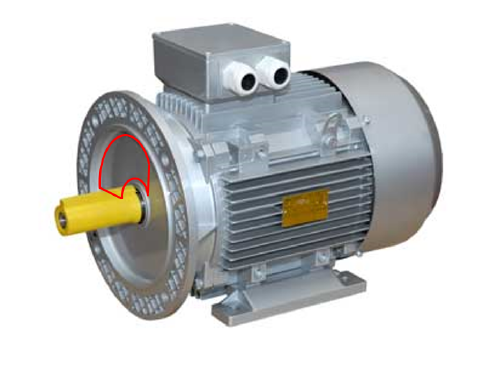
Figure 15. Position of the modified frontal motor flange.